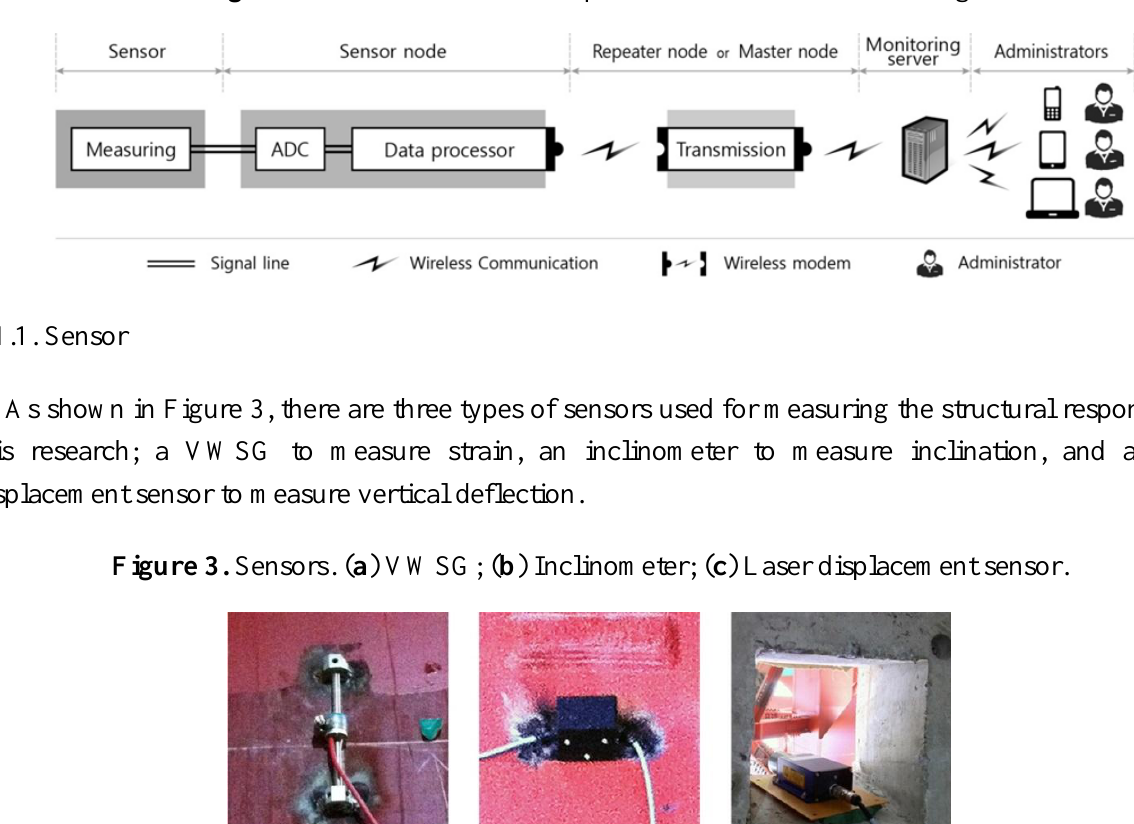
Figure 2. Function of each component for structural